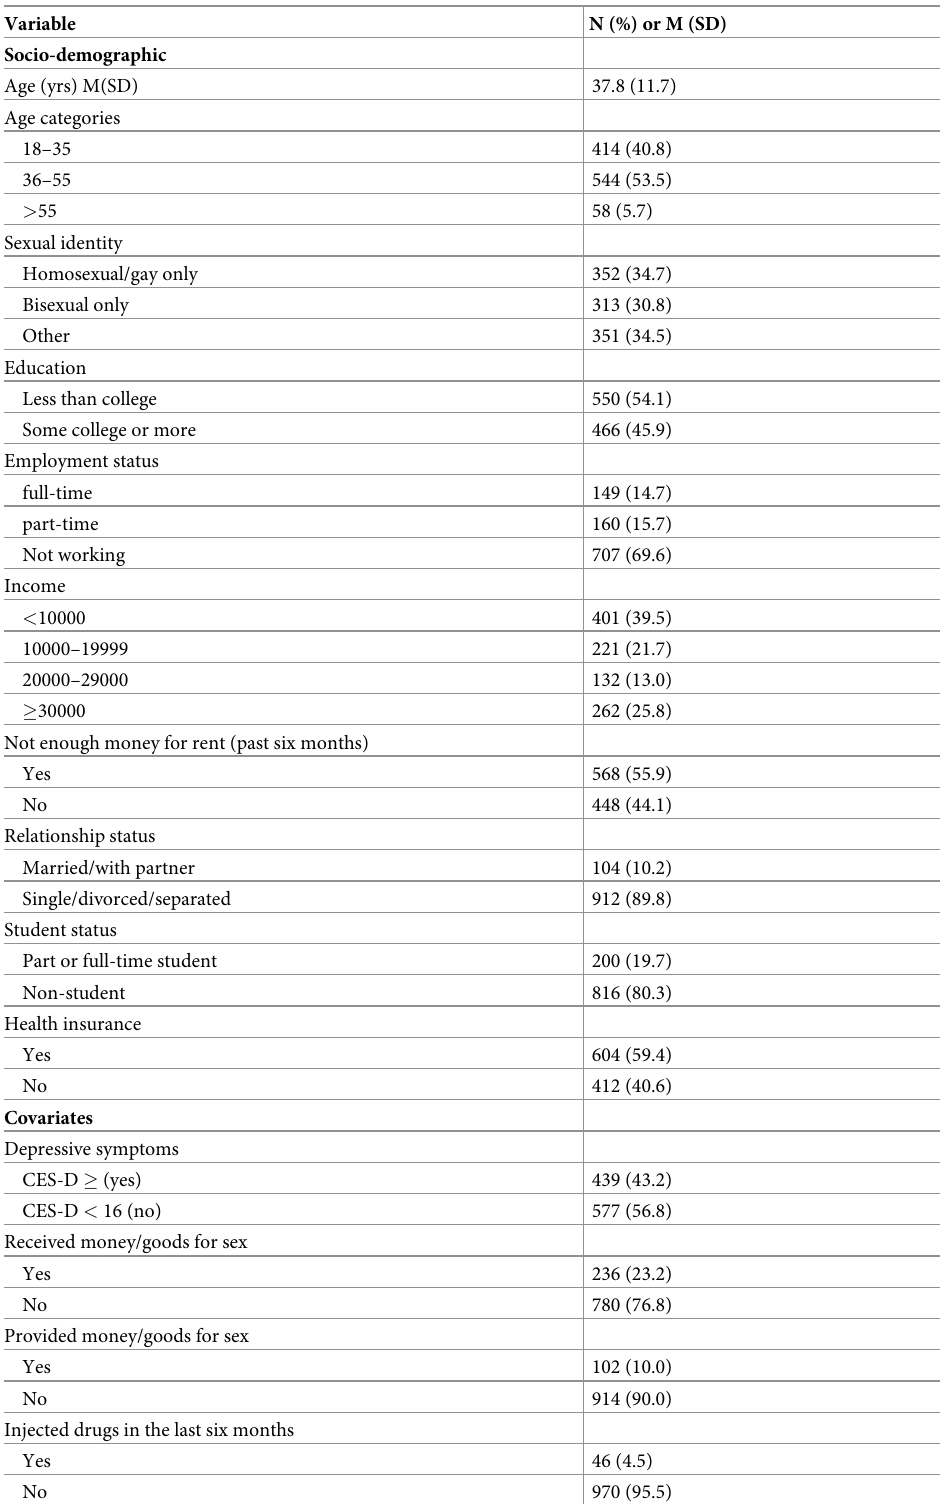
Table 1. Overall characteristics of the study sample (N =